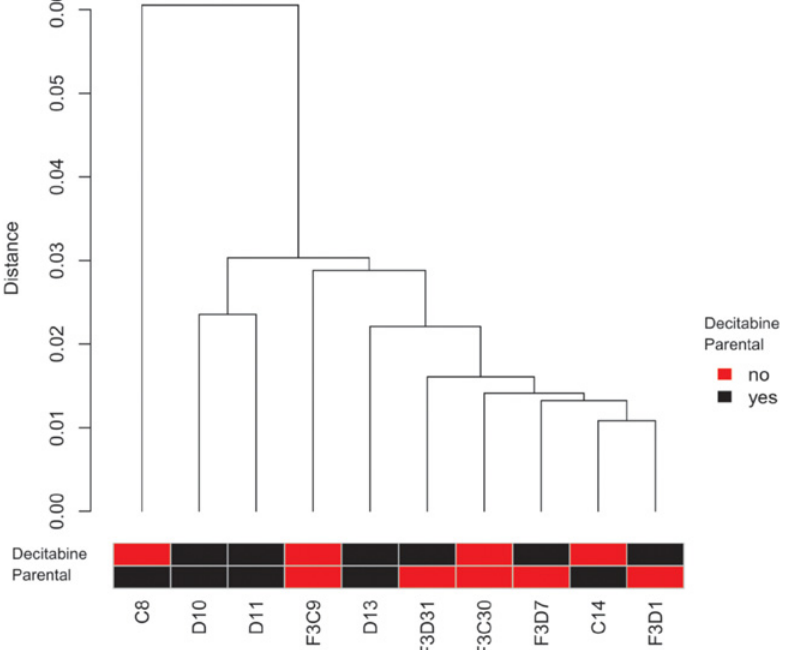
Fig 8. Clustering dendrogram based on DNA methylation of 1.35 × 106 CpG sites (min. coverage 10 reads) present in all samples. Analysed samples: Isolated DNA of spermatozoa of two vehicle-control animals ( C8 , C14 ) and two descendants (analysed sample from the F3-generation of C8: F3C9 and from the F3-generation of C14: F3C30 ) as well as of three decitabine treated animals ( D10 , D11 , D13 ) and three descendants (analysed samples from the F3-generation of D10: F3D1 and F3D31 and from the F3- generation of D11: F3D7 ). The distance is based on the Pearson ’ s correlation coefficient that ranges from +1 (two samples are most similar) to-1 (two samples are negatively correlated), while a 0 indicates absence of correlation. To visualize the difference between two samples the distance is calculated by converting the similarity matrix of the Pearson ’ s correlation coefficient into a distance matrix (1 — Pearson ’ s correlation coefficient) which is then used for hierarchical clustering. Due to the low distance between the samples, our analysis revealed the absence of large differences in the spermatozoal methylome of decitabine treated and untreated animals and their descendants.